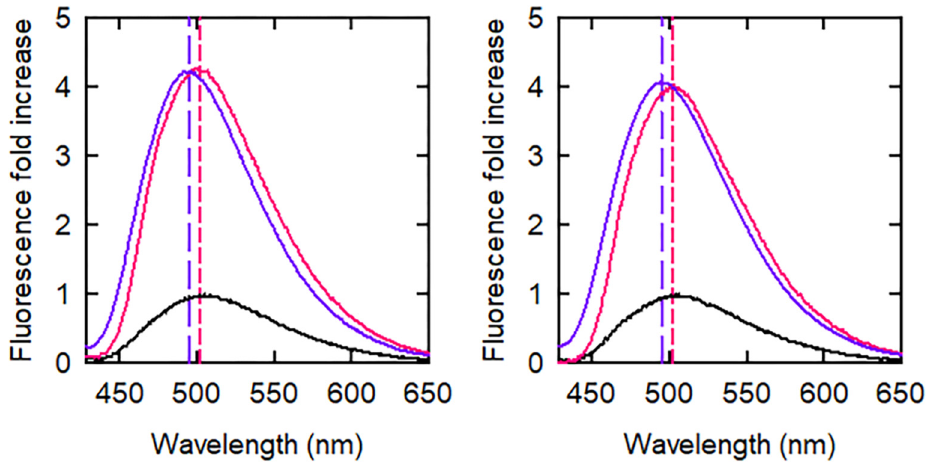
Figure 4. Changes in fluorescence emission spectra ( λ ex = 412 nm) of StOASS-A ( a ) or EcOASS-A ( b ) in the absence (black) and in the presence of saturating SAT (purple) or UPAR415 (pink). The peak is centered at 495 nm when CSC is formed and at 502 nm when the inhibitor is bound to OASS-A.